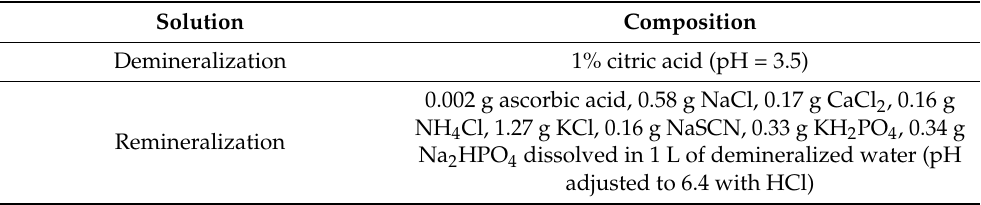
Table 1. Composition of the demineralization and remineralization solution (pH-cycling).